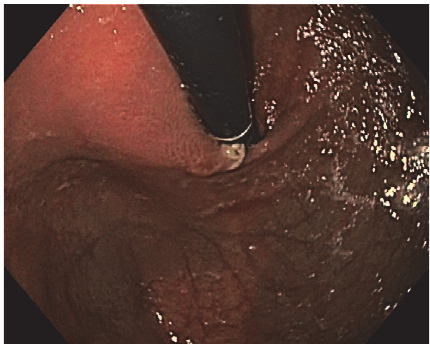
Figure 4: Endoscopic image of the gastric fundus on retroflexion showing evidence of esophagitis and normal surrounding stomach